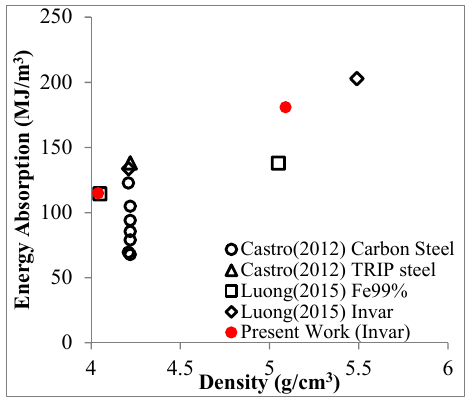
Figure 12. SEM images of fracture face on the Invar ‐ 10CS under quasi ‐ static loading at magnification of ( a ) ×400; and ( b ) ×1500.